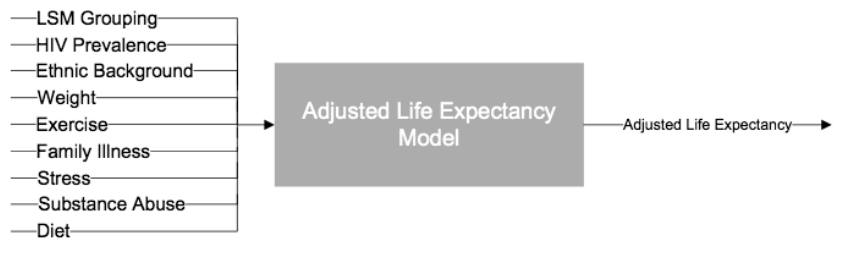
FIGURE 4: Flow chart showing the ale inputs and outputs Source: Created by